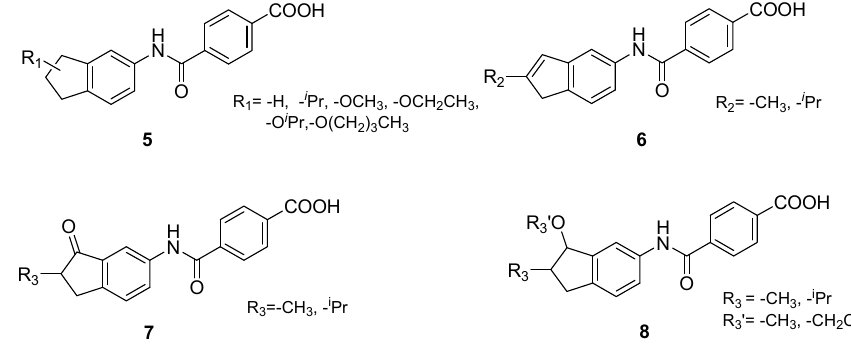
Figure 2. Chemical structures of indene derived compound series 6 – 8 .